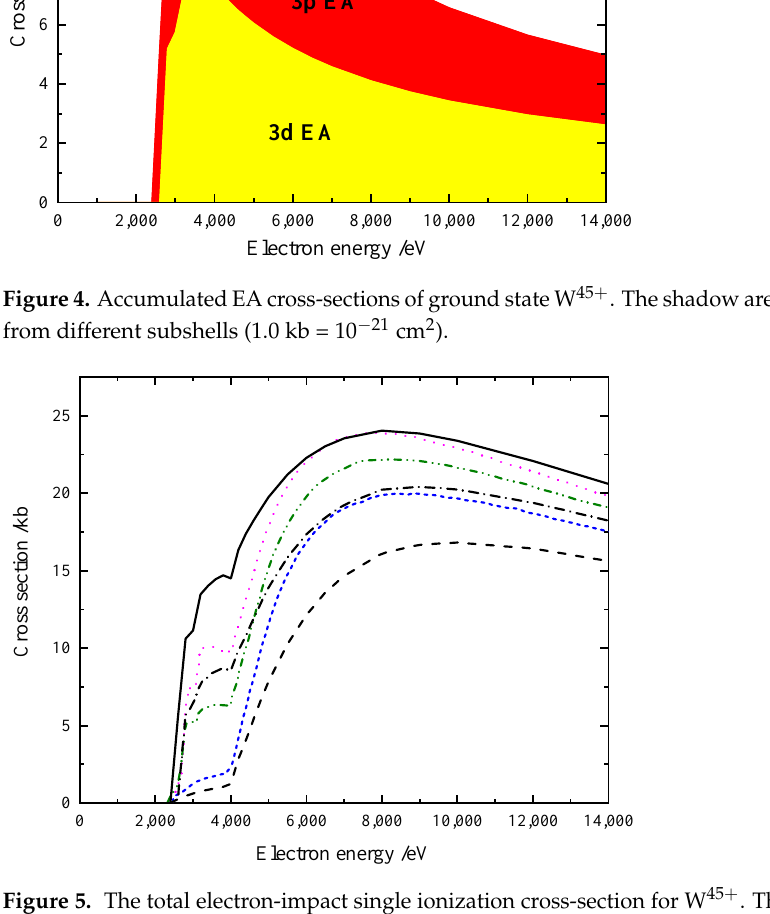
Figure 5. The total electron-impact single ionization cross-section for W 45 + . The color curves are the calculated results of Loch et al. [11]. Blue dashed curve: CADW calculations for direct ionization. Green dot–dashed curve: CADW calculations for direct and indirect ionization with full branching. Magenta dot curve: CADW calculations for direct ionization and LLDW calculations for indirect ionization with full branching. Black dashed curve: LLDW calculations for direct ionization. Black dot–dashed curve: the total cross-section which contains 3 d → nl excitation cross-sections with full branching. Black solid curve: the total cross-section which contains 3 d → nl and 3 p → nl excitation cross-sections with full branching (1.0 kb = 10 − 21 cm 2